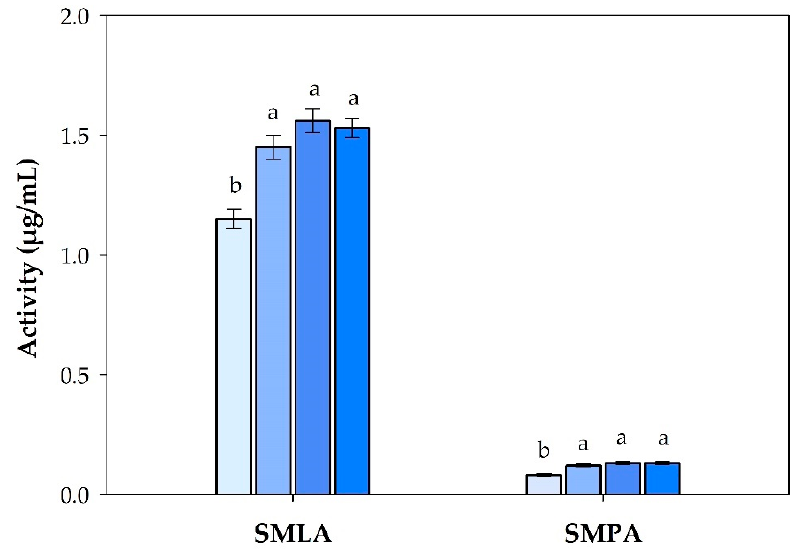
Figure 1. The activity ( µ g mL − 1 ) of lysozyme and peroxidase in skin mucus of Nile tilapia 15 d post-vaccination. Treatment 1 (T1)—control, Treatment 2 (T2)—formalin-killed S. agalactiae immersion vaccine, Treatment 3 (T3)—formalin-killed S. agalactiae injectable oil-based vaccine, Treatment 4 (T4)—formalin-killed S. agalactiae water-based oral vaccine. The presence of different letters in each group indicates a significant difference ( p < 0.05). SMLA, skin mucus lysozyme activity; SMPA, skin mucus peroxidase activity.